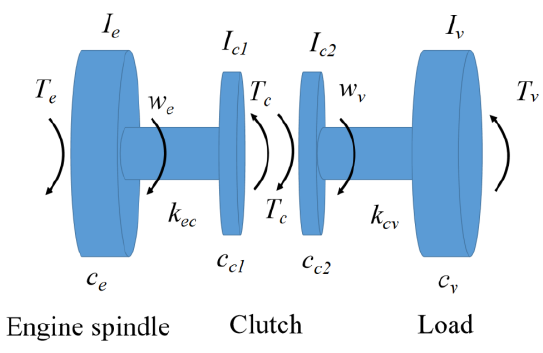
Figure 5. Dynamic model of the friction clutch.